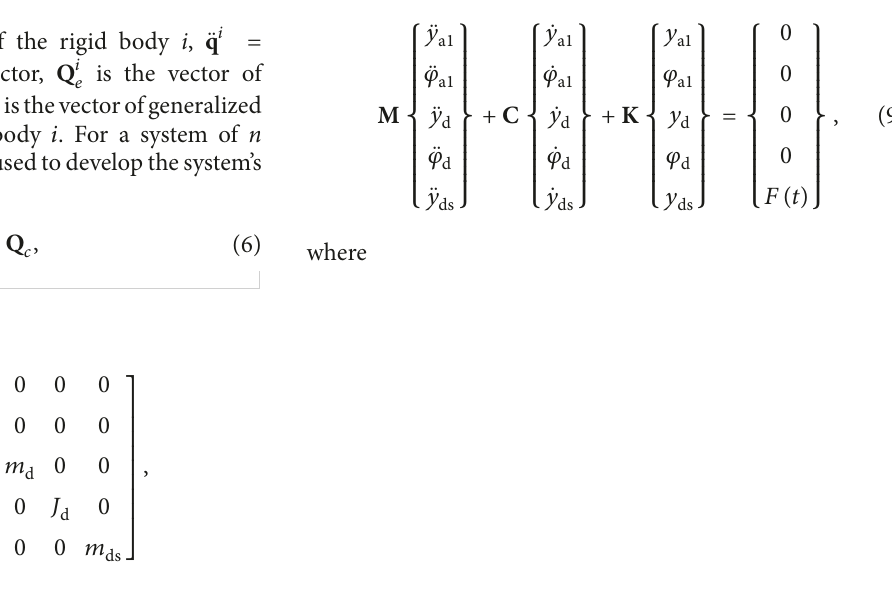
is again in direct contact with the vibrating surface and this is simulated with an external force 𝐹 . The distribution of the external force exerted on the surface is considered uniform, therefore 𝐹/2 for the 2-Phalanx and 𝐹/3 for the 3-Phalanx model. The tissue properties between the bones and the skin are modeled using the translational stiffness ( 𝑘 m , 𝑘 p ) and damping ( 𝑐 m , 𝑐 p ). The interphalangeal joints are represented by the rotational and translational stiffness ( 𝑘𝑟 mp , 𝑘 mp , 𝑘𝑟 pi , and 𝑘 pi ) and the damping ( 𝑐𝑟 mp , 𝑐 mp , 𝑐𝑟 pi , and 𝑐 pi ). The contribution or addition to the measured AM is denoted by 𝑚 a 2 , 𝑚 a 3 , 𝑘𝑟 a 2 , 𝑘 a 2 , 𝑘𝑟 a 3 , 𝑘 a 3 , 𝑐𝑟 a 2 , 𝑐 a 2 , 𝑐𝑟 a 3 , and 𝑐 a 3 for the 2-Phalanx and 3-Phalanx models